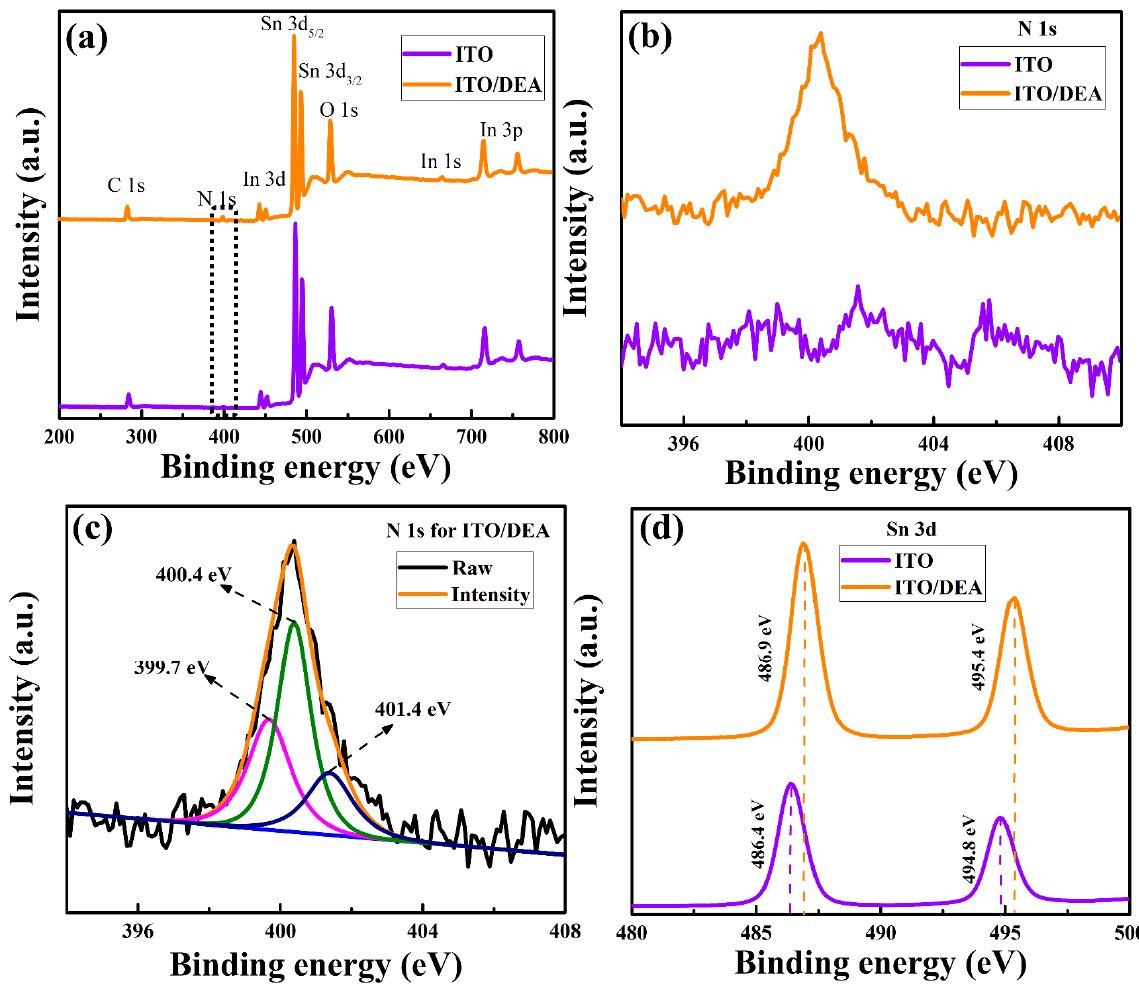
Figure 1. XPS spectra of ITO substrate and ITO/DEA substrate ( a ), N 1s spectra of ITO substrate and ITO/DEA substrate ( b ), analysis of N 1s spectra of ITO/DEA substrate ( c ), and Sn 3d spectra of ITO substrate and ITO/DEA substrate ( d ).